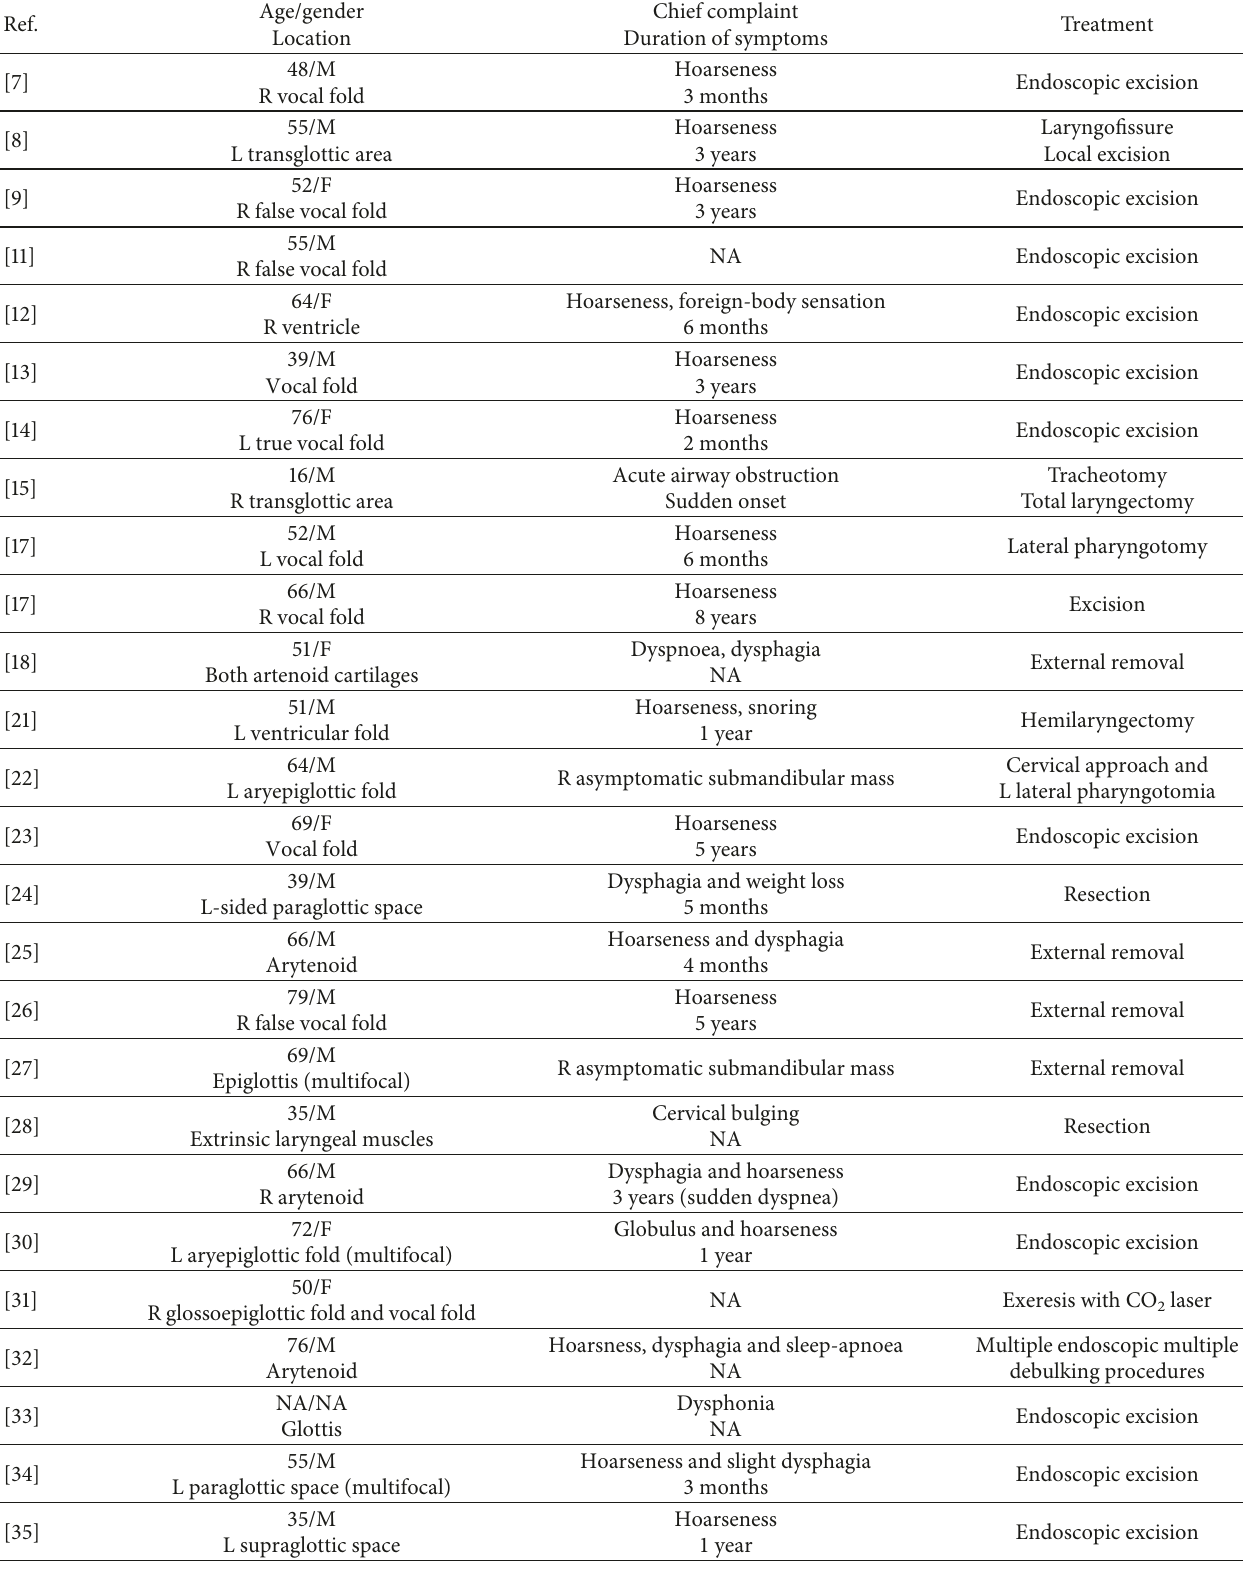
Table 1: Clinical comparative synopsis of our case with the other cases of adult-type RM of the larynx reported in the literature, including the present case.